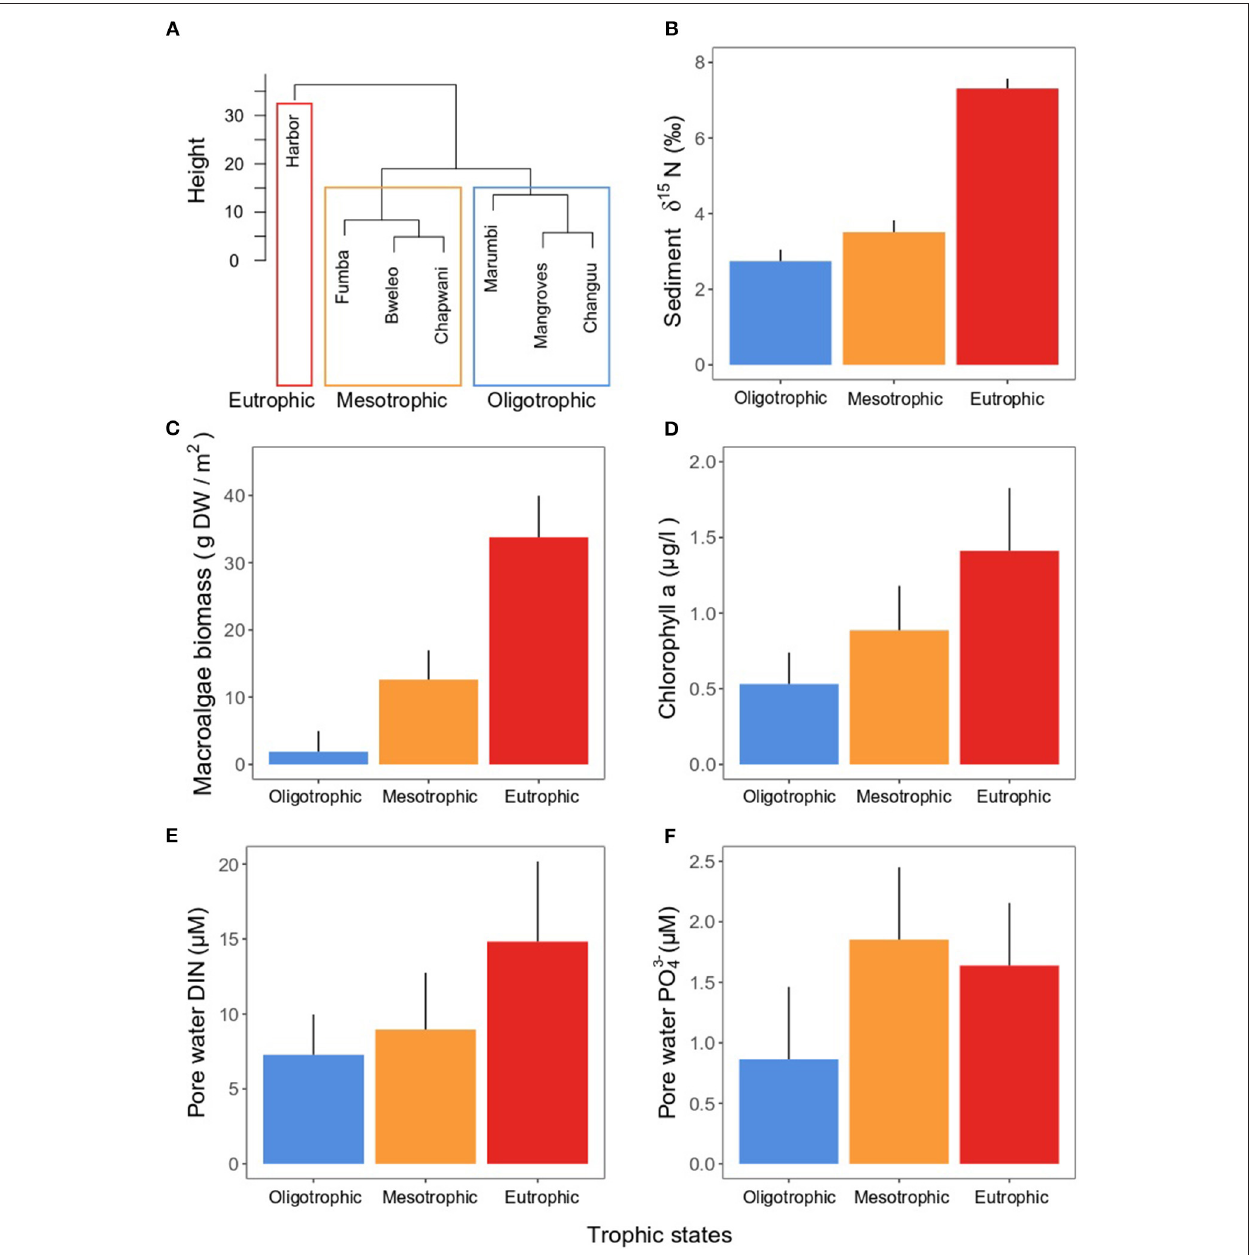
FIGURE 4 | (A) Ward clustering of sites according to trophic state. Mean ( ± SE) (B ) sediment δ 15 N, (C) macroalgae biomass, (D) chlorophyll- a in the water column, (E) pore water DIN, and (F) pore water PO 3 − 4 , taken as proxies for eutrophication indicators. Means were calculated among samples taken in the sites (three sites for the oligotrophic and mesotrophic states, one site for the eutrophic state). For macroalgae biomass, n = 45 for the oligo- and mesotrophic states, and n = 15 for the eutrophic state. For δ 15 N, chlorophyll- a , pore water DIN, and pore water PO 3 − 4 , n = 15 for the oligo- and mesotrophic states, and n = 5 for the eutrophic state.